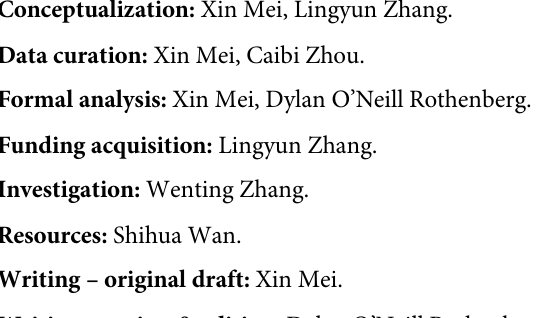
S1 Fig. Molecular docking results of DFR with DHQ and DHM. Two DHM molecules, named as MYC4341 and MYC4342 in the template of 2IOD.pdb, were herein represented as DHM_1 and DHM_2,